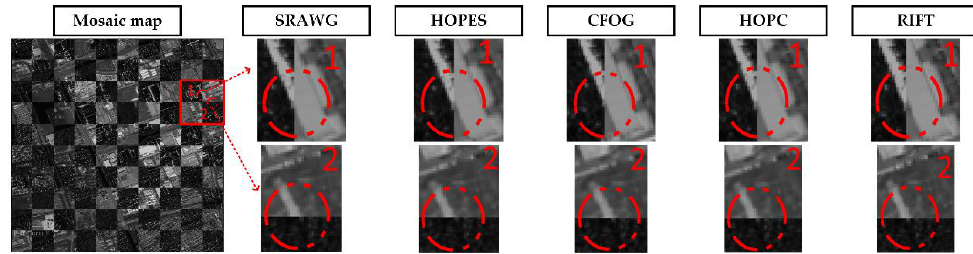
Figure 17. Mosaic map for Case 2. The geometric stitching effect of the two images can be observed from the center of the area circled by circles 1 and 2.